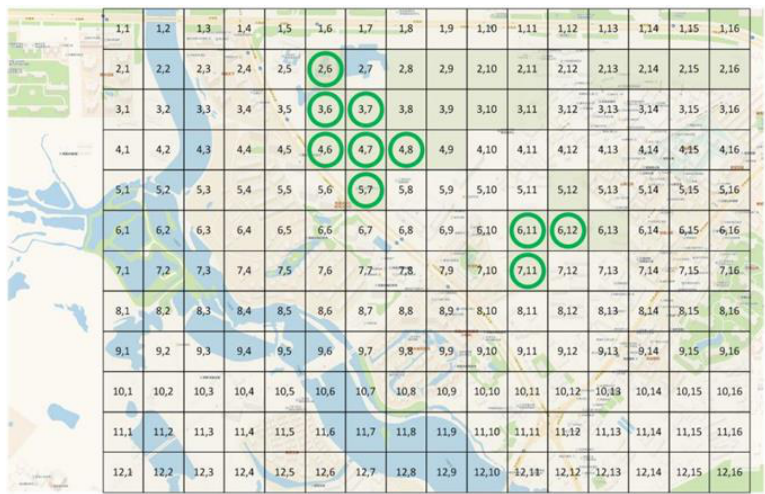
Figure 11. Final optimization scheme.